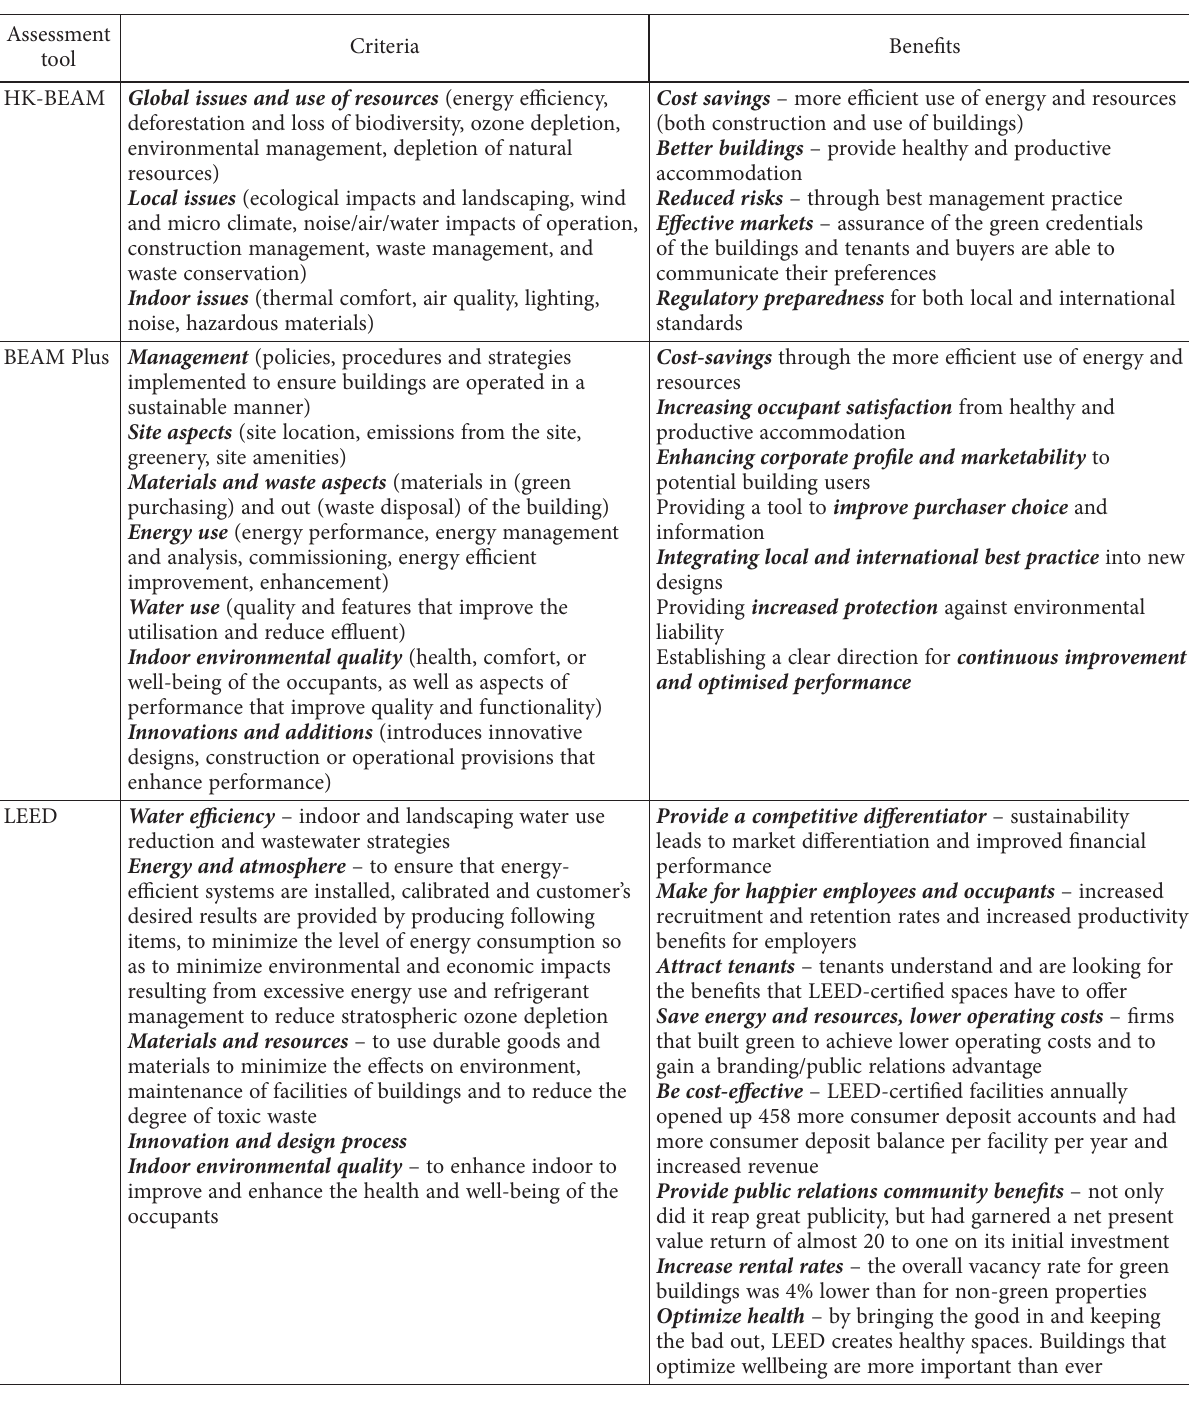
Table 1. Assessment criteria and benefits of HK-BEAM, BEAM Plus and LEED (sources: extracted from Mohammad and Amato (2006), Table 1; WBCSD (2008); Ahankoob, Morshedi, and Rad (2013); Hong Kong Green Building Council (2016); US Green Building Council (2016a))